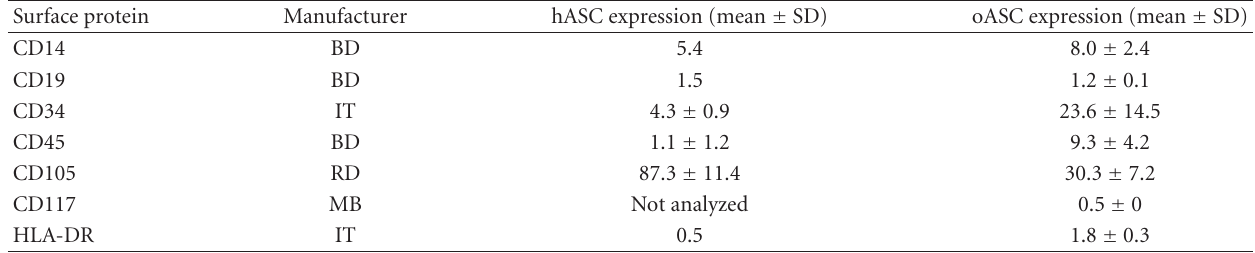
Table 1: Phenotypic characterization of human (hASC) and ovine (oASC) adipose stem cells by flow cytometric analysis of 10,000 cells. Data are presented as mean ± standard deviation (SD).